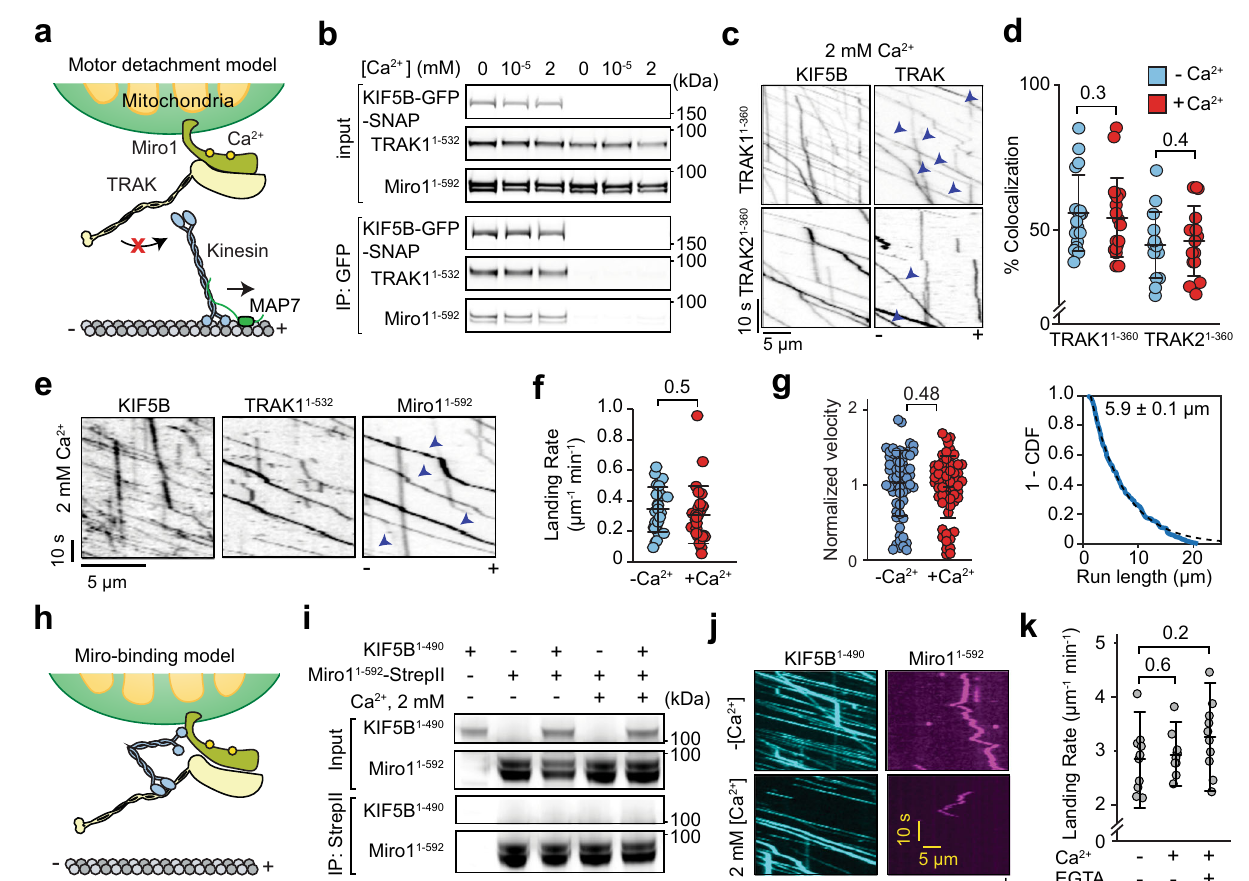
Fig. 6 Kinesin-driven transport of Miro1/TRAK1 is not disrupted by Ca 2+ . a The